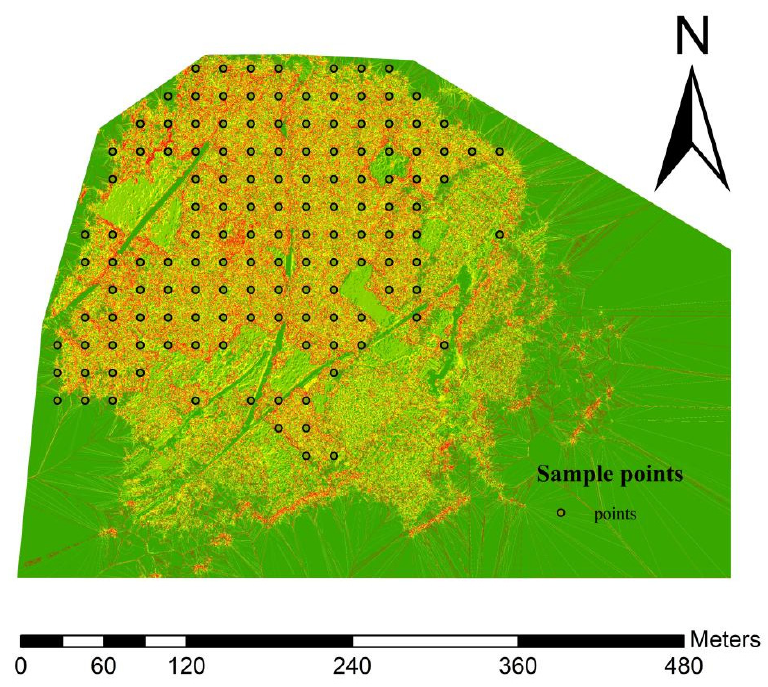
Figure 6. Sample area sampling points.